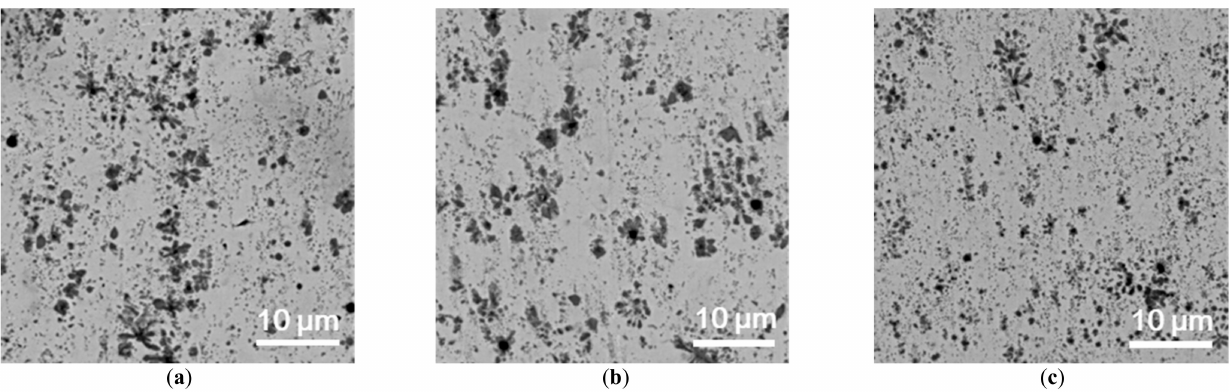
Figure 7. Area distribution of reinforcing particles in EEMMC1.5-T, EEMMC1.5-C, and EEMMC1.5-B.